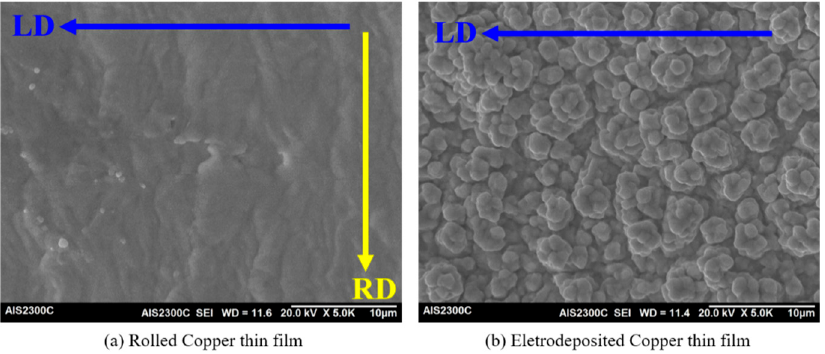
Figure 2. Copper thin film surface image by process method from SEM (Scanning Electron Microscope). ( a ) the surface image of rolled copper ( b ) the surface image of electrodeposited copper.